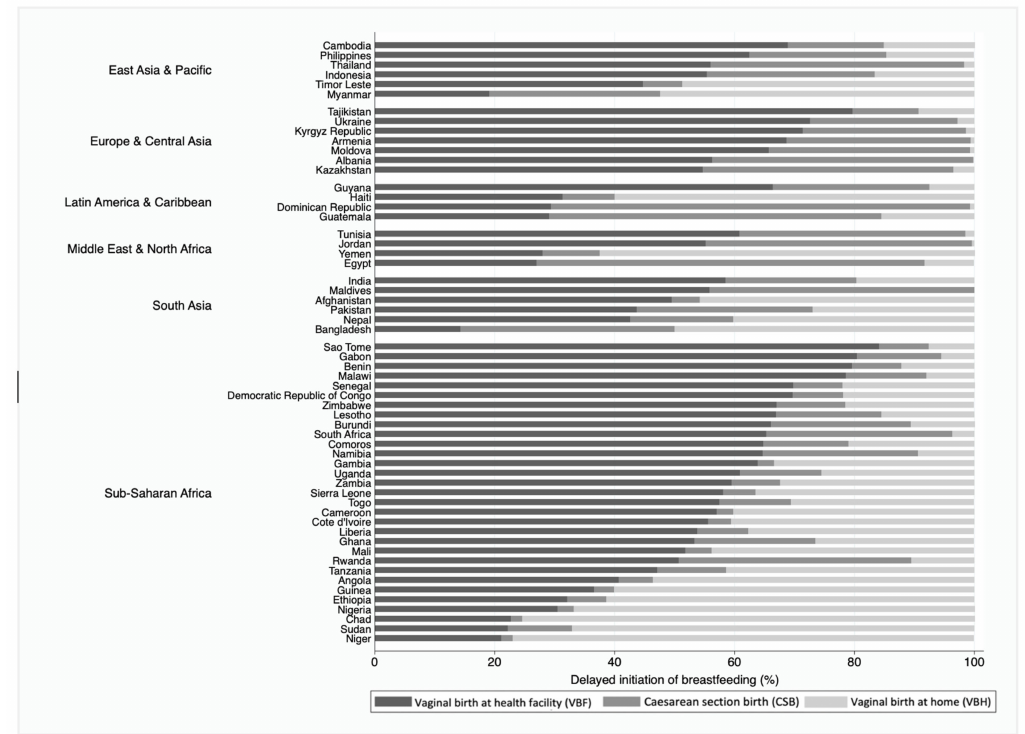
Figure 1. Mode of childbirth among the delayed initiators in each